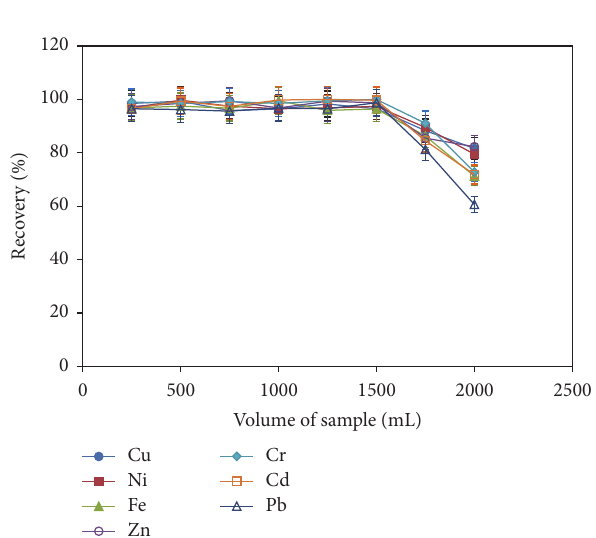
Figure 1: Effect of sample volume (pH = 7.5; amount of metal ions: 30 𝜇 g Pb(II) and Cr(III), 20 𝜇 g Fe(III), 15 𝜇 g Cu(II) and Ni(II), and 10 𝜇 g Cd(II) and Zn(II); CR amount: 1.0mmol/L; amount of resin: 0.5 g; flow rate: 5.0 mL/min; final volume: 5mL and 𝑁 = 3 ).